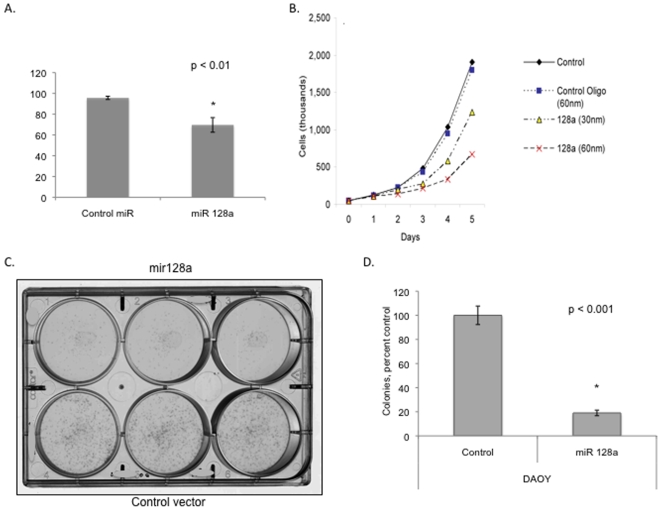
Inhibition of medulloblastoma cell growth by microRNA-128a.A) MiR-128a inhibits medulloblastoma cell proliferation as measured by MTT assay. (p<01) B) Number of Daoy cells as measured by trypan blue dye exclusion assay. C) Decreased colony formation in miR-128a transfected cells (top row is miR-128a vector, bottom row is control vector). D) Colony counts in triplicate of 2 independent experiments. (p<0.001)